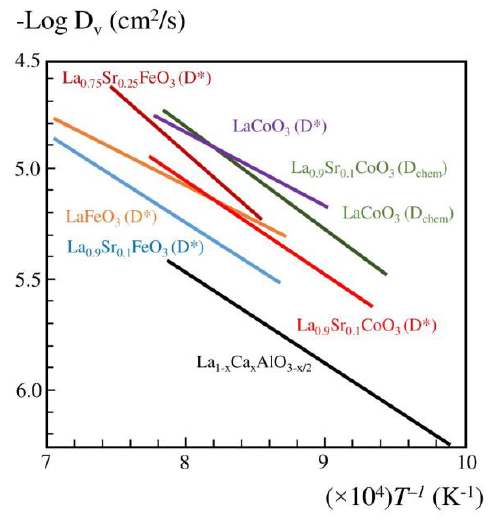
Figure 10. Diffusivity of oxygen ions in various perovskite oxides employed in an oxygen permeation membrane. D*, D v calculated from the tracer diffusion coefficient; D chem , D v calculated from the chemical diffusion coefficient. Adapted from Ref. [97].